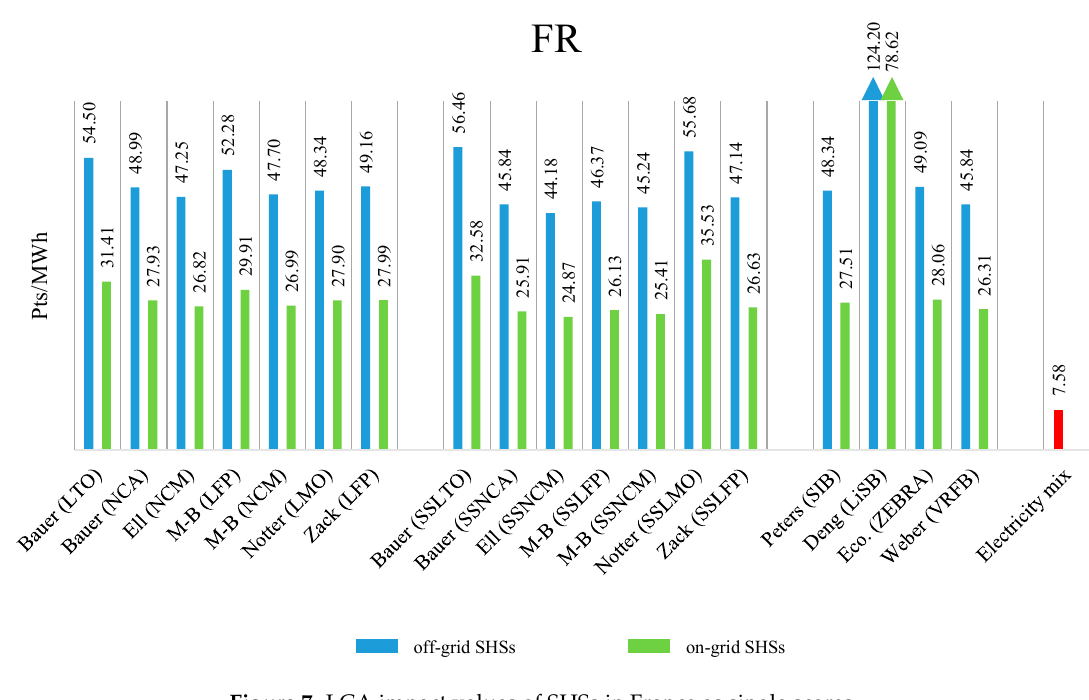
Figure 7. LCA impact values of SHSs in France as single scores.